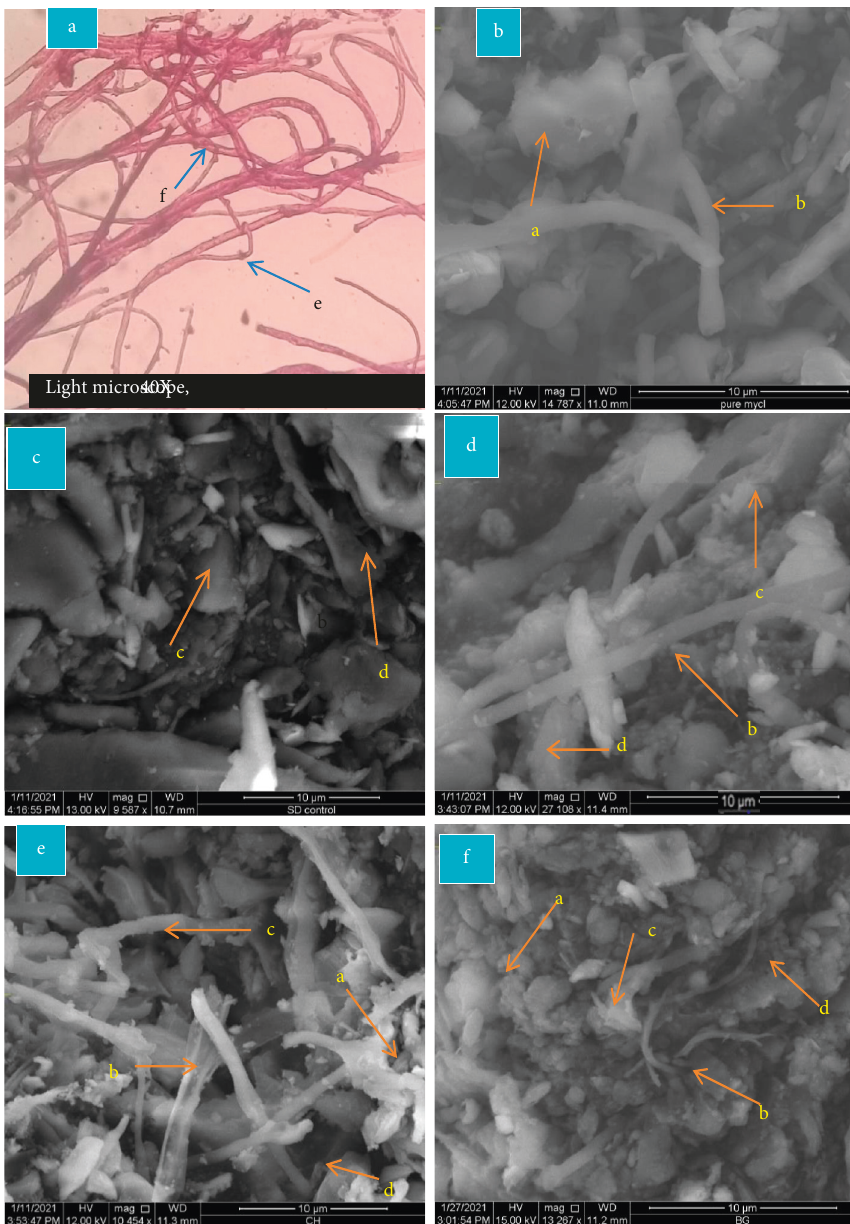
Figure 5: Microscopic images of mycelium grown on different substrates. (a) Electro microscopic image of pure mycelium. (b) SEM image of pure mycelium. (c) SEM image of pure SD. (d) SEM image of inoculated SD. (e) SEM image of the inoculated coffee husk. (f) SEM image of inoculated Bg, where (A) fused hyphae, (B) mycelium, (C) substrate, (D) air voids, (E) hyphae septa, and (F) hyphae anastomosis under a light